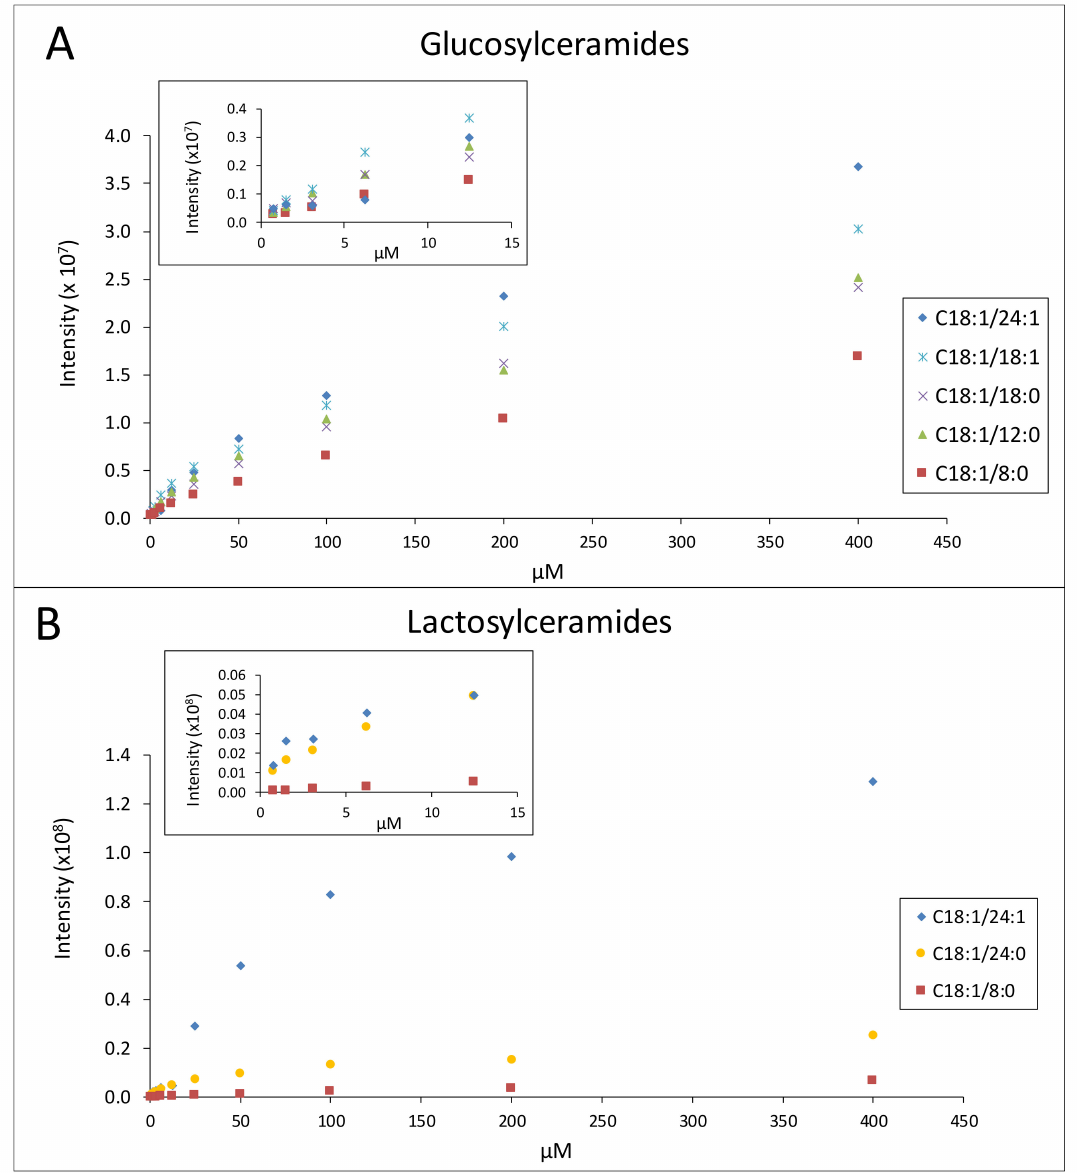
Figure 7. MS response of five di ff erent species of GluCer ( A ) and three di ff erent species of LacCer ( B ). The reproducibility of these measurements, as defined by the coe ffi cients of variation (CVs), are shown in Table 4. The high CV for LacCer measured in human milk was due to the low concentrations (close to the LOQ)